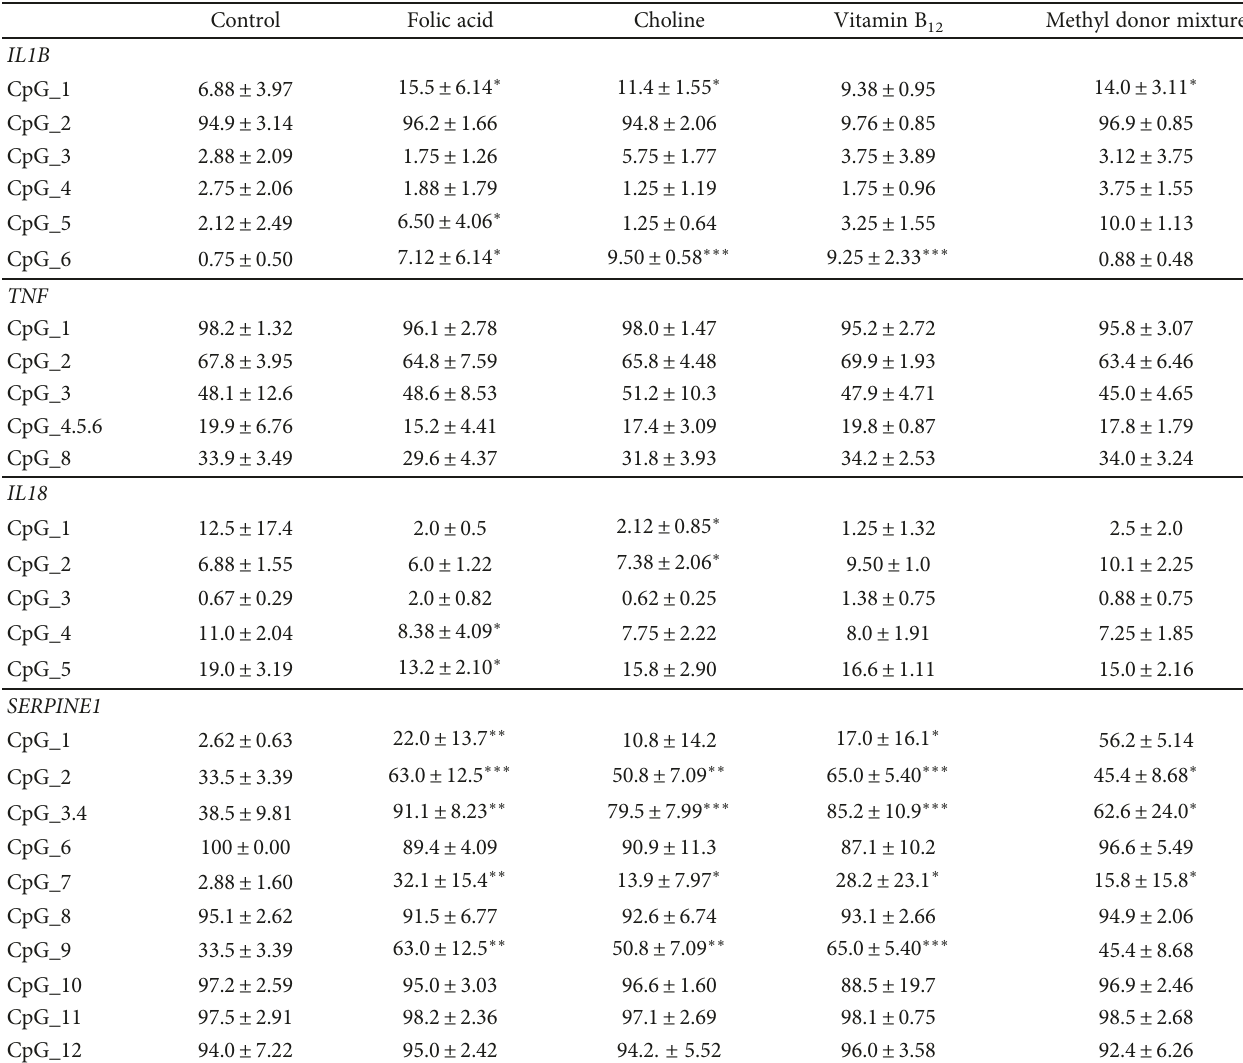
Table 1: CpG methylation levels (as percentage) in IL1B , TNF , IL18 , and SERPINE1 genes after the incubation of THP-1 monocytes with folic acid, choline, vitamin B , and the methyl donor mixture, measured by MassARRAY. Unpaired Student ’ s t -test was used to compare 12